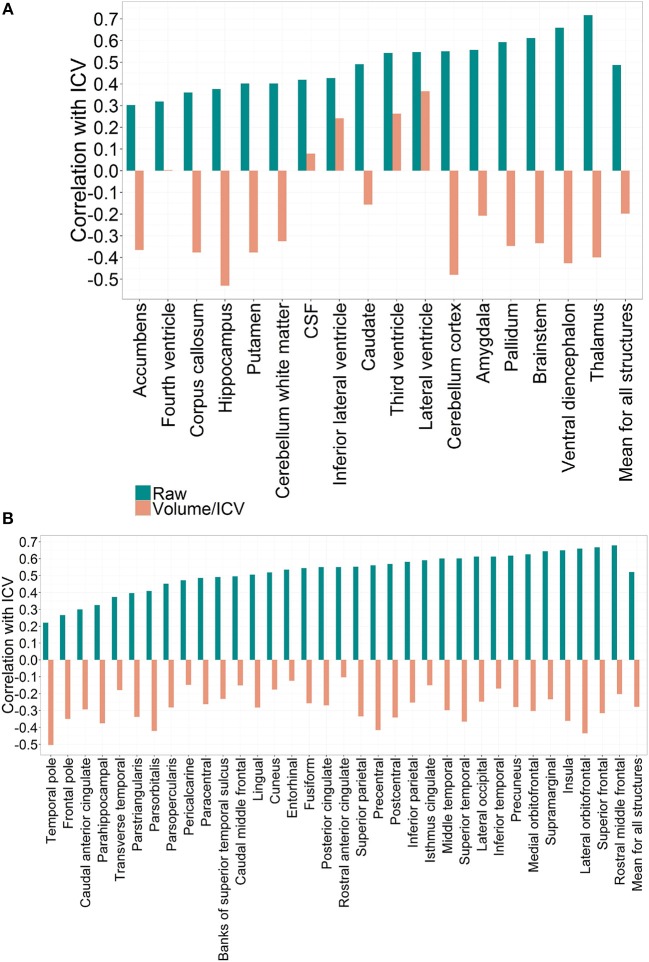
(A) Correlation patterns for individual regional subcortical volumes in the PIVUS cohort using different normalization methods. Mean correlation coefficient with ICV:Rraw = 0.49 (0.12), Rproportion = −0.20 (0.28), Rresidual = 0. (B) Correlation patterns created by individual regional cortical volumes in the PIVUS cohort under different normalization settings. Mean correlation coefficient with ICV:Rraw = 0.52 (0.12), Rproportion = −0.28 (0.10), Rresidual = 0.